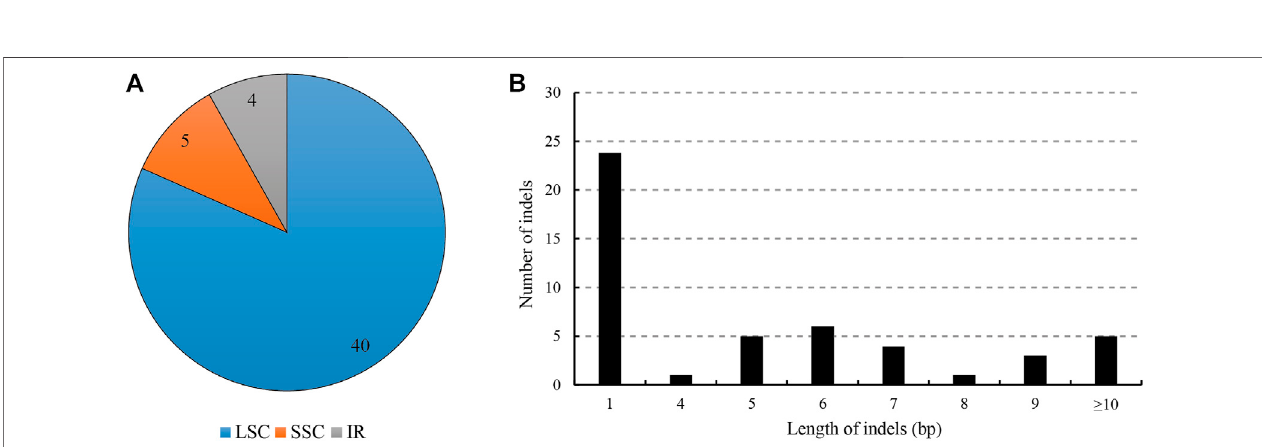
Frontiers in Genetics |